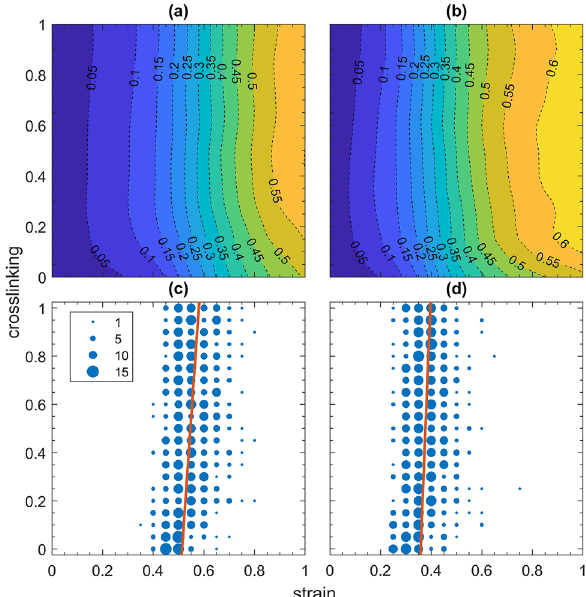
Figure 3. Fraction of collagen recruitment (indicated by the colors and isopleths) as a function of cross- linking ( ρ ) and strain. ( a ) Corresponds to the healthy condition and ( b ) to the severely fibrotic condition. Corresponding plots of the collagen mechanical percolation threshold for ( c ) the healthy condition and ( d ) the severely fibrotic condition. The diameters of the blue circles correspond to the number of simulations exhibiting mechanical percolation at the corresponding values of cross-linking and strain. The orange lines in ( c , d ) are trend lines calculated by weighted least